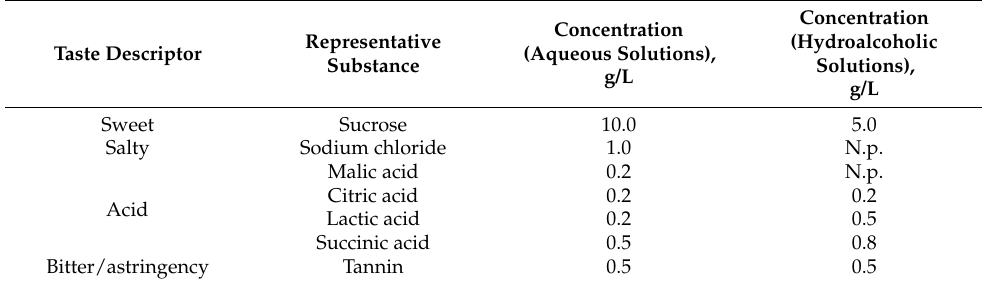
Table 1. Concentrations used for the preparation of aqueous and hydroalcoholic solutions (ethanol 12%, v / v ) for enzyme activity